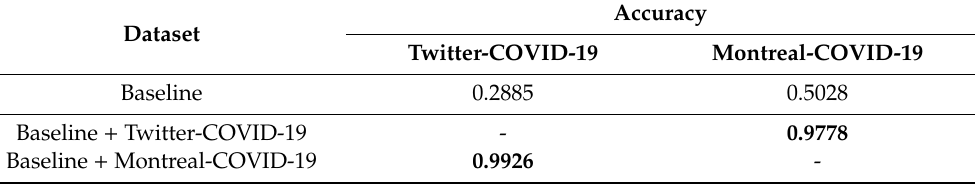
Table 11. Performance metrics achieved using augmenting training data directly with one of the COVID-19 CXR collections toward classifying another COVID-19 CXR collection as belonging to the viral pneumonia